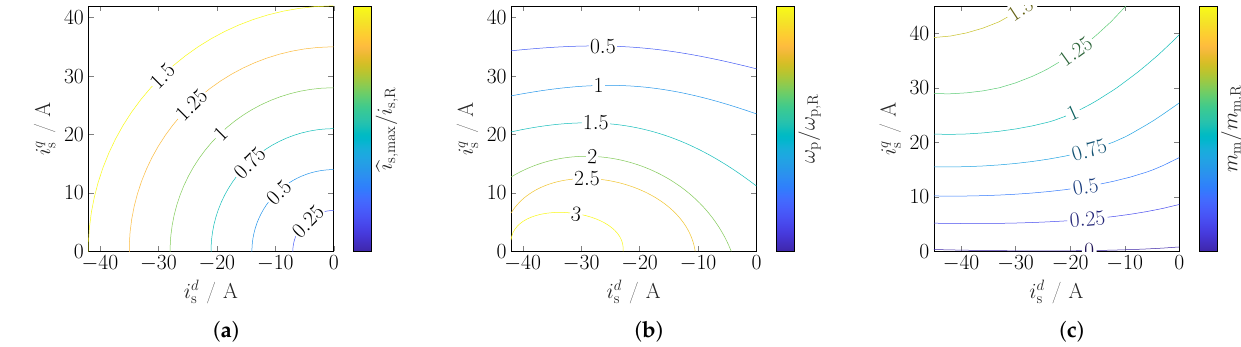
Figure 5. Illustration of machine constraints and reference torque in current locus for multiples of rated current i s,R , angular velocity ω p,R and machine torque m m,R . ( a ) Current circles. ( b ) Voltage ellipses. ( c ) Torque